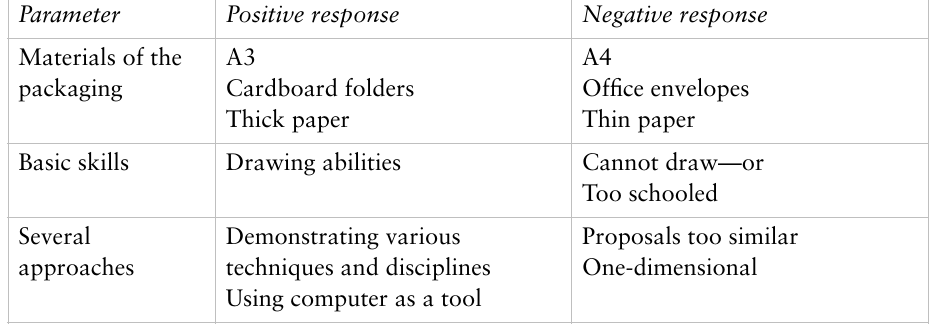
Table 4. Overview of evaluators’ parameters (c ontinued on page 139).